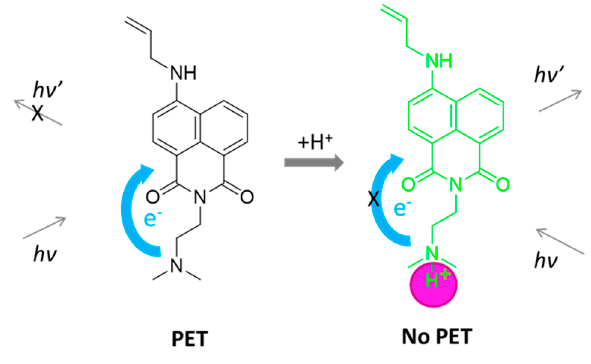
Scheme 3. Proposed PET mechanism and its quenching in acidic medium of NI3.